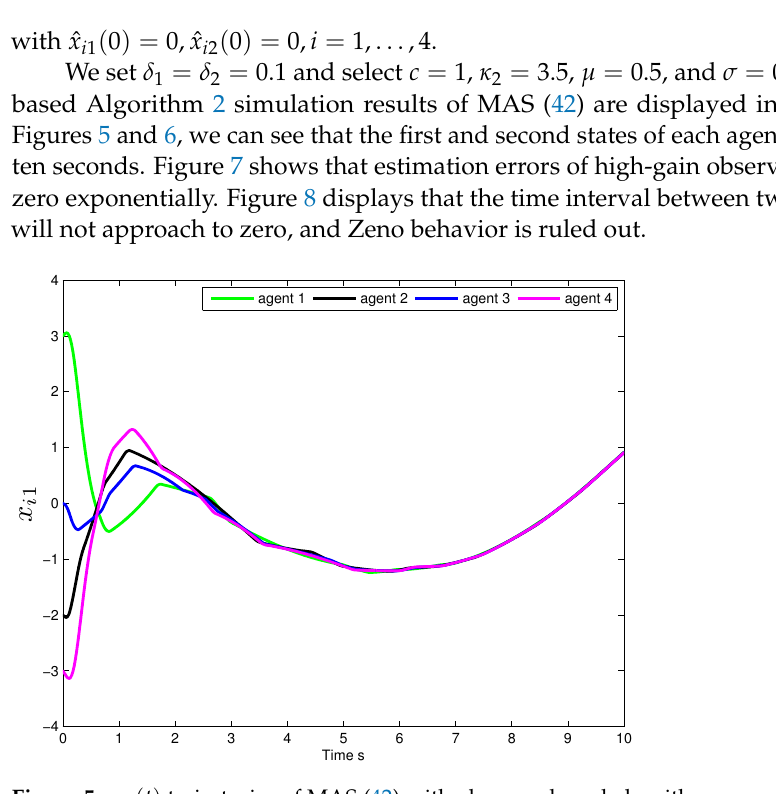
Figure 5. x i 1 ( t ) trajectories of MAS (42) with observer-based